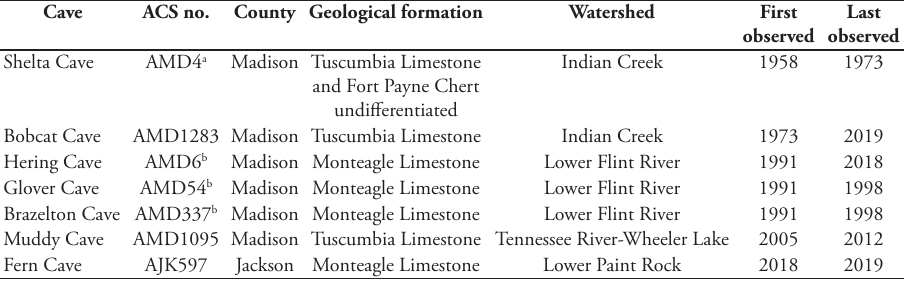
Table 1. Confirmed occurrences of Palaemonias alabamae in Madison and Jackson counties,